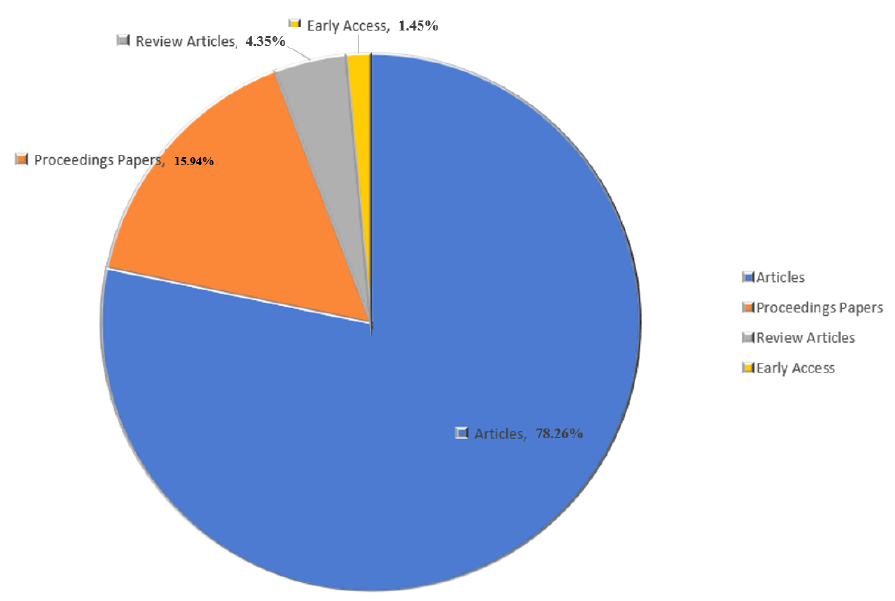
Figure 2. Types of all 69 documents.